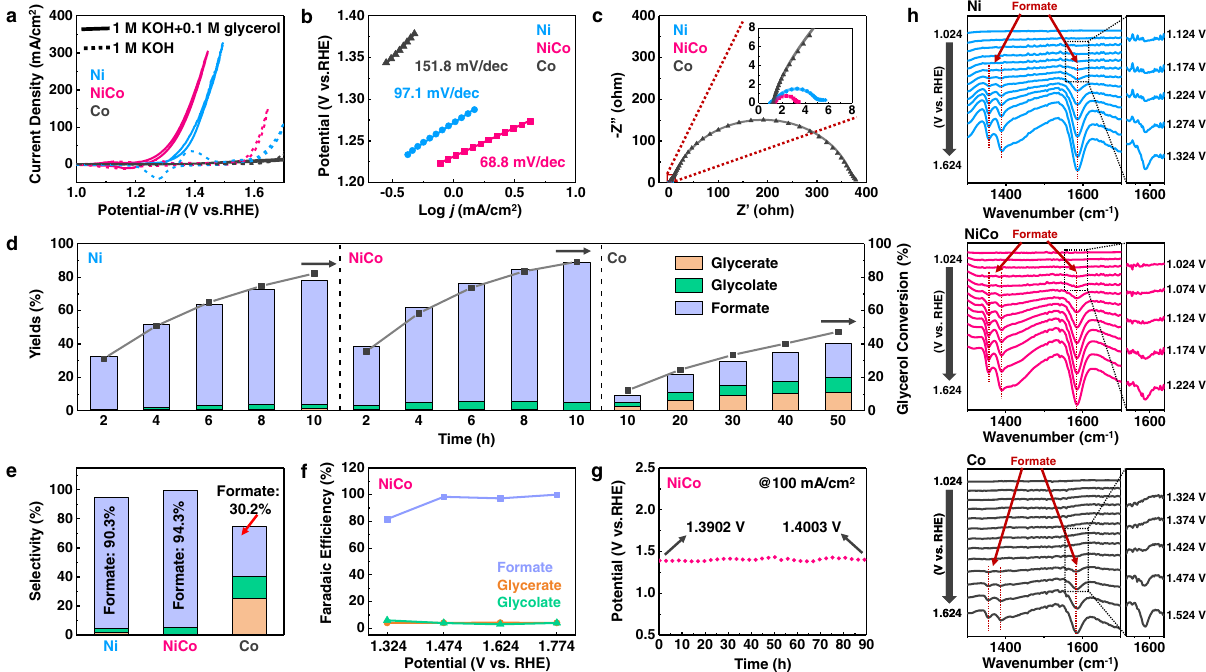
Fig. 1 Evaluation of the electrocatalytic performance towards glycerol oxidation reaction (GOR). a Cyclic voltammetry curves of Ni, NiCo, and Co hydroxide in 1 M KOH solution with (solid line) or without (dash line) 0.1 M glycerol. b Tafel curves and c , electrochemical impedance spectroscopies of Ni, NiCo, and Co hydroxide for GOR. The EIS measurements were performed at the potential of 1.324 V (vs. RHE). d The evolution of glycerol conversion and product yields as a function of electrolysis time at the potential of 1.624 V (vs. RHE) in 50 mL electrolyte of 1 M KOH with 0.1 M glycerol. The corresponding i – t curves were shown in Supplementary Fig. 18. e The selectivity of different products after electrolyzing at 1.624 V (vs. RHE) for 10 h in 50 mL electrolyte of 1 M KOH with 0.1 M glycerol. f The evolution of Faradaic ef fi ciency as a function of applied potential on NiCo hydroxide with the same amount of total charge passed (1000 C). g Chronopotentiometry curve for NiCo hydroxide acquired at the current density of 100 mA/cm 2 . h In-situ infrared spectra of Ni, NiCo, and Co hydroxide obtained during the linear sweep voltammetry (LSV) measurement. The right panels are the enlarged fi gures of the dash line